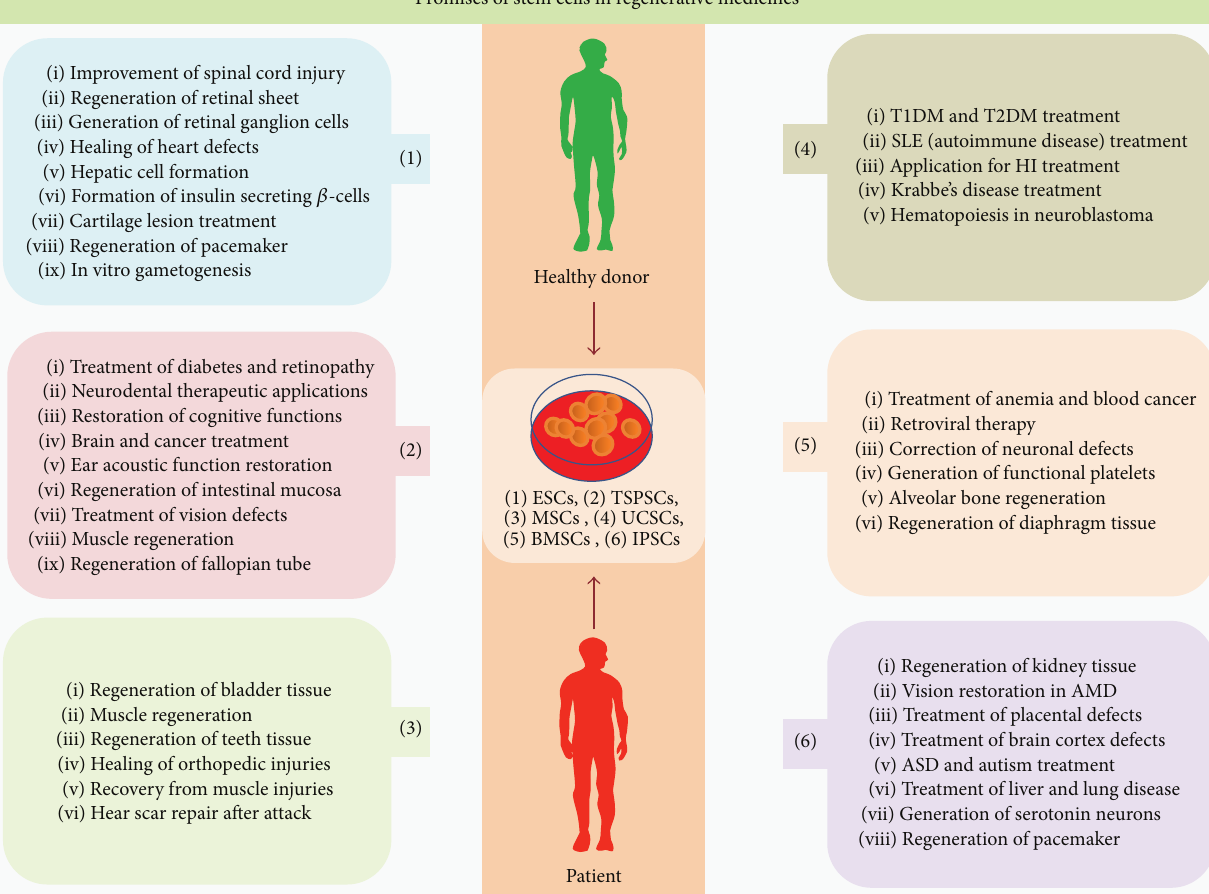
immune suppressant is recommended [6]. Stem cells